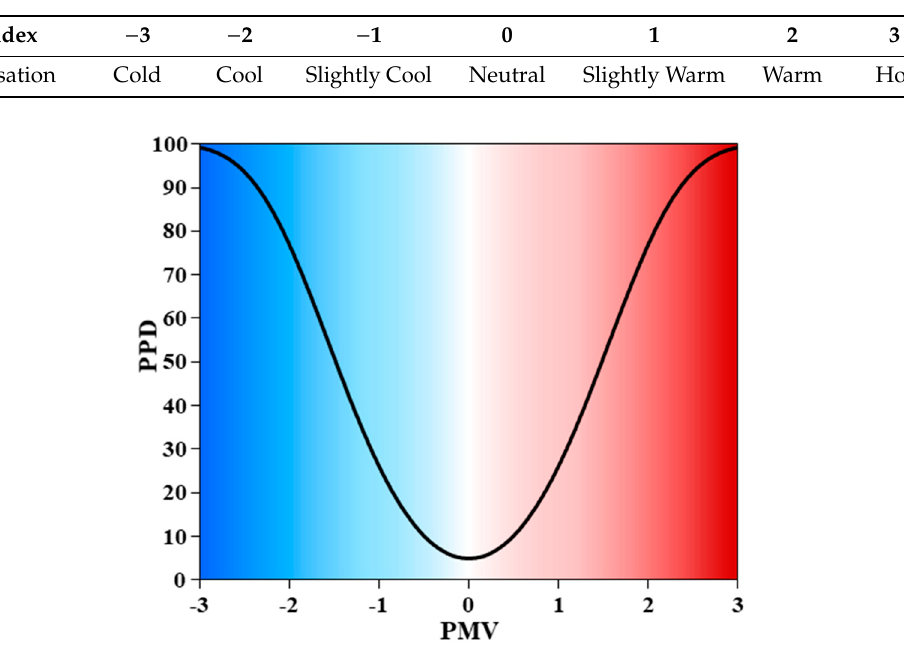
Table 1. Index of predicted mean vote (PMV).